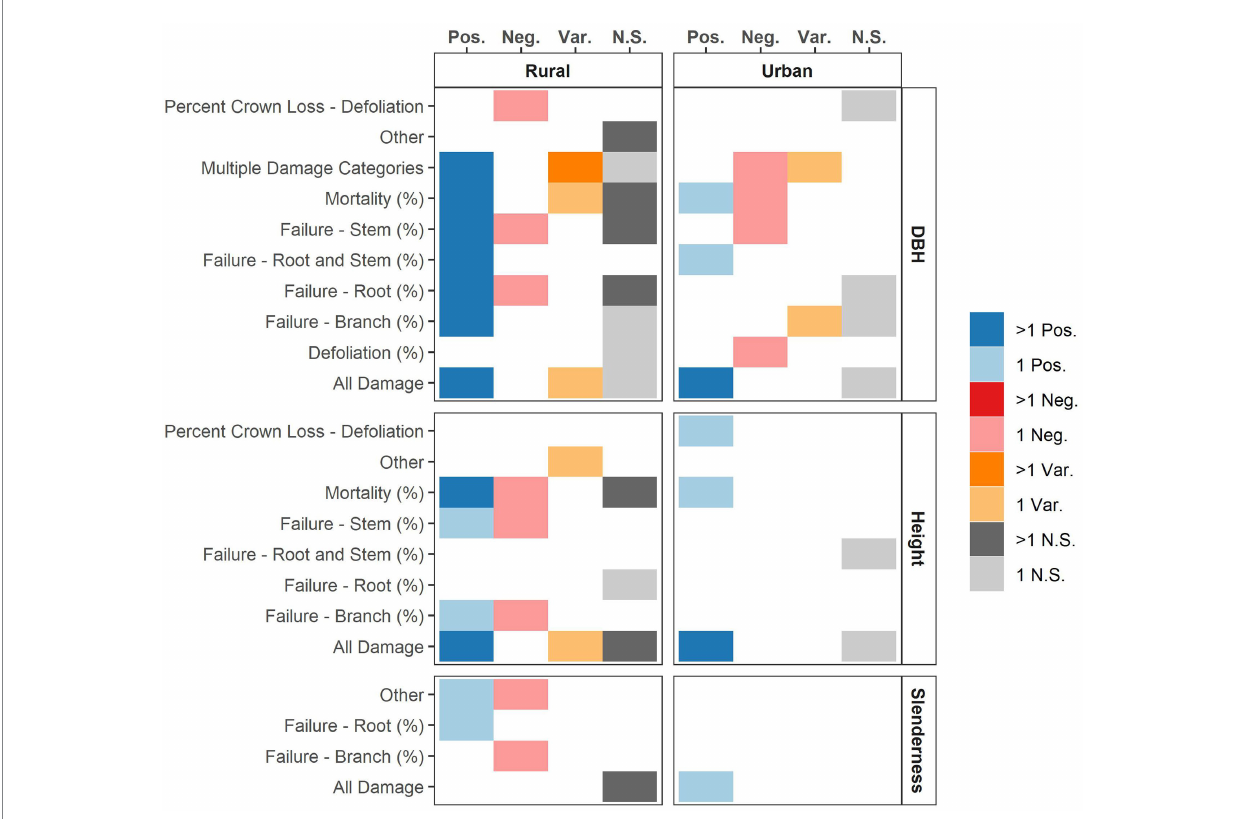
FIGURE 8 The number of studies that observed positive, negative, variable, or non-significant relationships between predicting factors and different types of tropical cyclone damage to trees. >1 indicates relationship type was observed in more than one study. S., significant difference among categories; Pos., positive relationship; Neg., negative relationship; Var., variable relationship (e.g., non-linear); N.S., no significant relationship; Cond., tree condition; Mgmt., management; TC, tropical